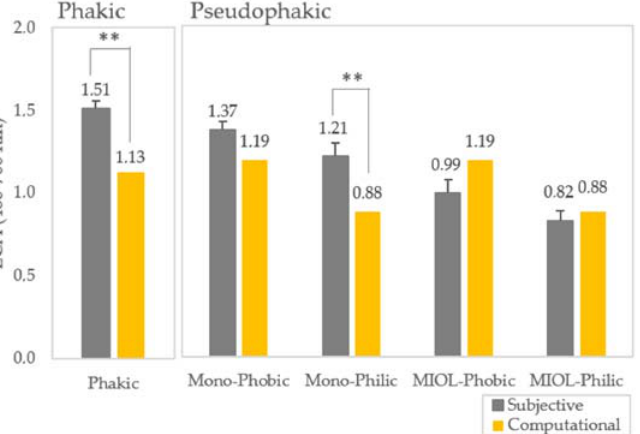
Figure 7. Average LCA (480–700 nm) for far vision for phakic and pseudophakic eyes obtained from subjective (solid gray bars) and computational (solid yellow bars) methods for far vision. ** Highly statistically significant ( p < 0.01) differences between conditions. Error bars indicate inter-subject variability.